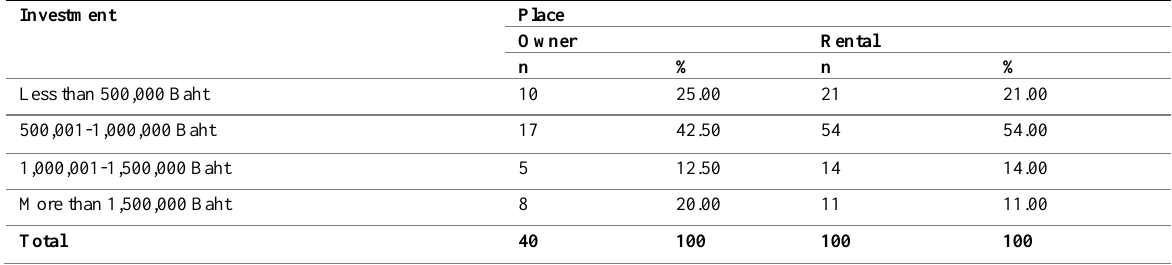
Table 2: Results of the Place and Investment of the Respondents